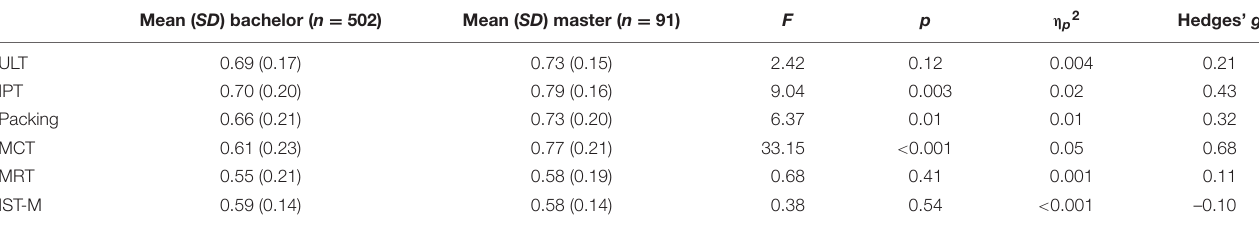
TABLE 3 | Mean values and MANOVA results comparing test performance of beginner and advanced students.